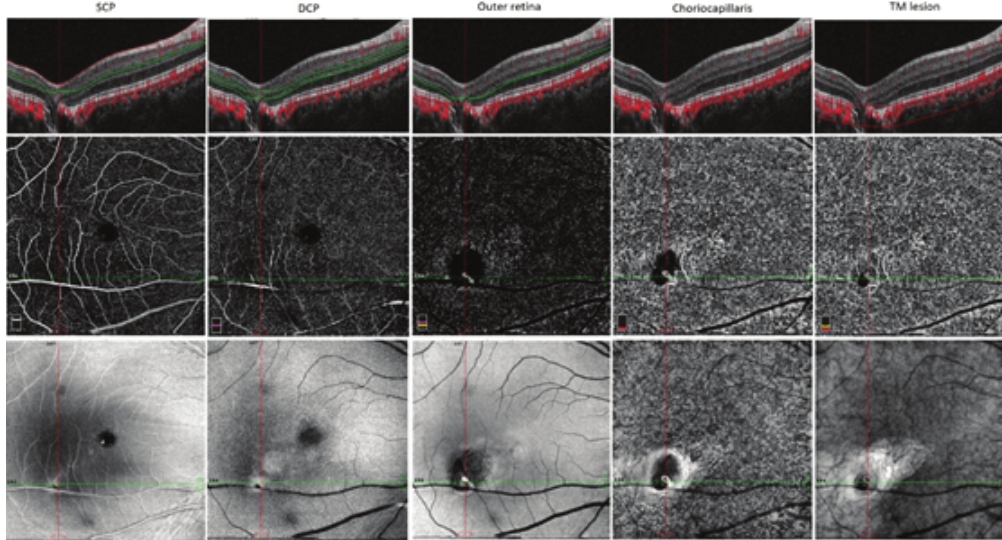
Figure 2. OCT angiography findings of patient 6 showing the torpedo lesion with focal choroidal excavation with presence of choroidal neovascular membrane. Columns 1–5 show the automated segmentation scans through the superficial capillary plexus, deep capillary plexus, outer retina, choriocapillaris, and manual segmentation across the torpedo lesion with focal choroidal excavation, respectively. Note the decreased flow areas and vessel density in the area of torpedo lesion. A choroidal neovascular membrane can be identified as well.